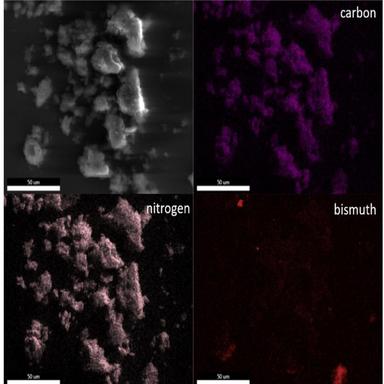
SEM-EDS analysis of Bi/g-C3N4 – maps of elements: carbon, nitrogen and bismuth.